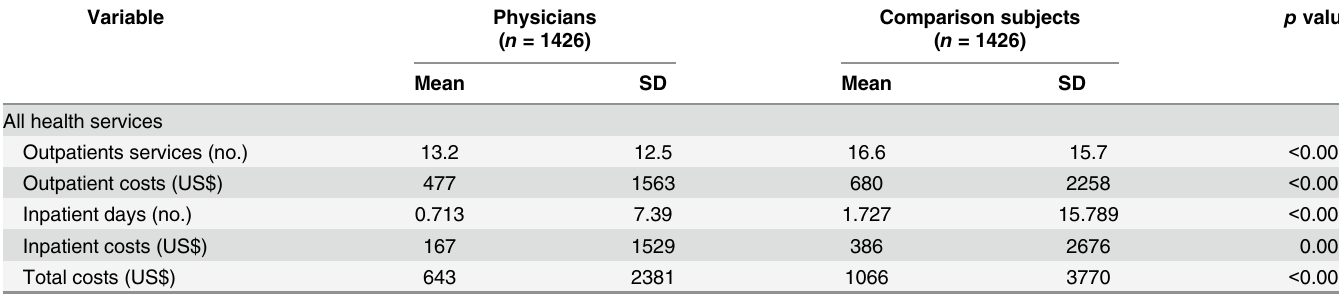
Table 2. Use and costs (US$) of healthcare services in the year 2010 by physicians and comparison subjects.